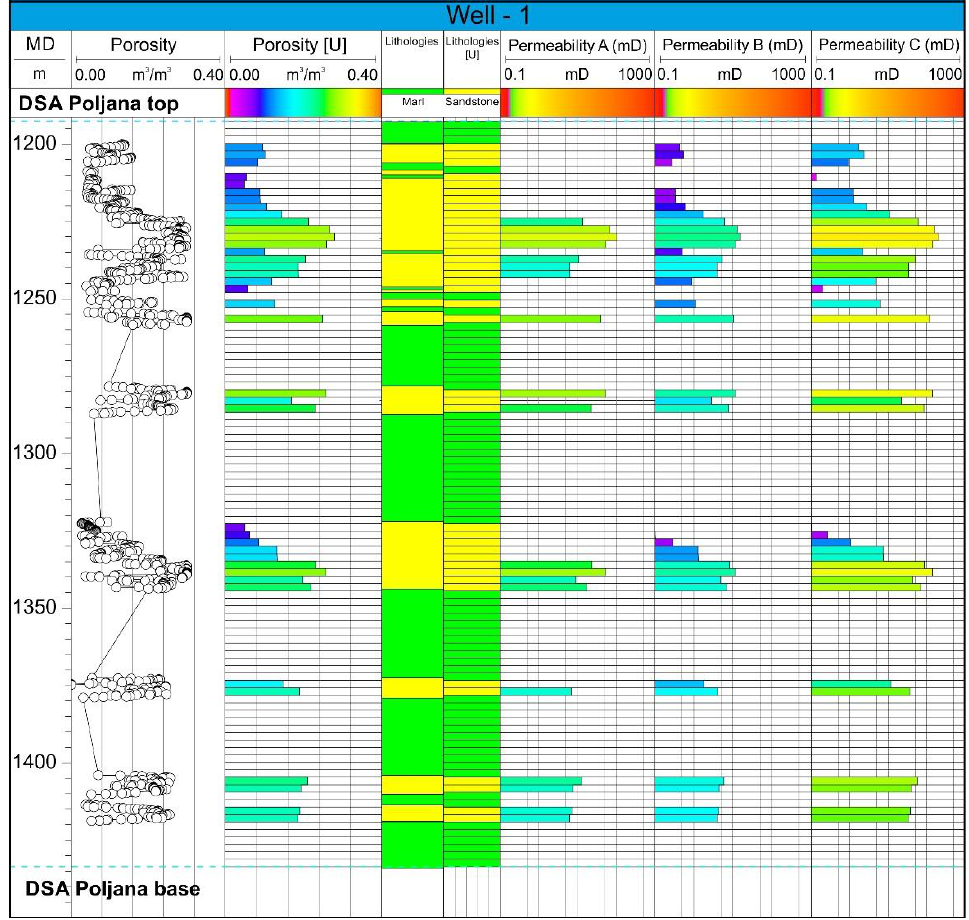
Figure 5. Selected well log from the porosity and permeability model of the DSA Poljana for three permeability cases: A — calculated from the relationship shown in Figure 4 with an 18% porosity cut-off, B — calculated based on the Slichter equation in [61], and C — calculated based on the Timur equation in [61].